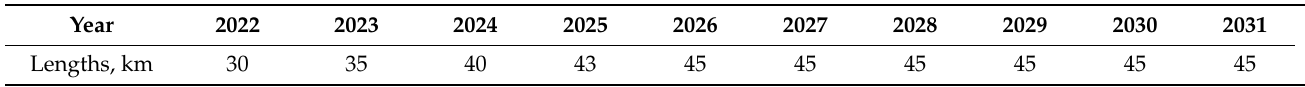
Table 5. Lengths in kilometres planned to be replaced (source: authors based on the analysed